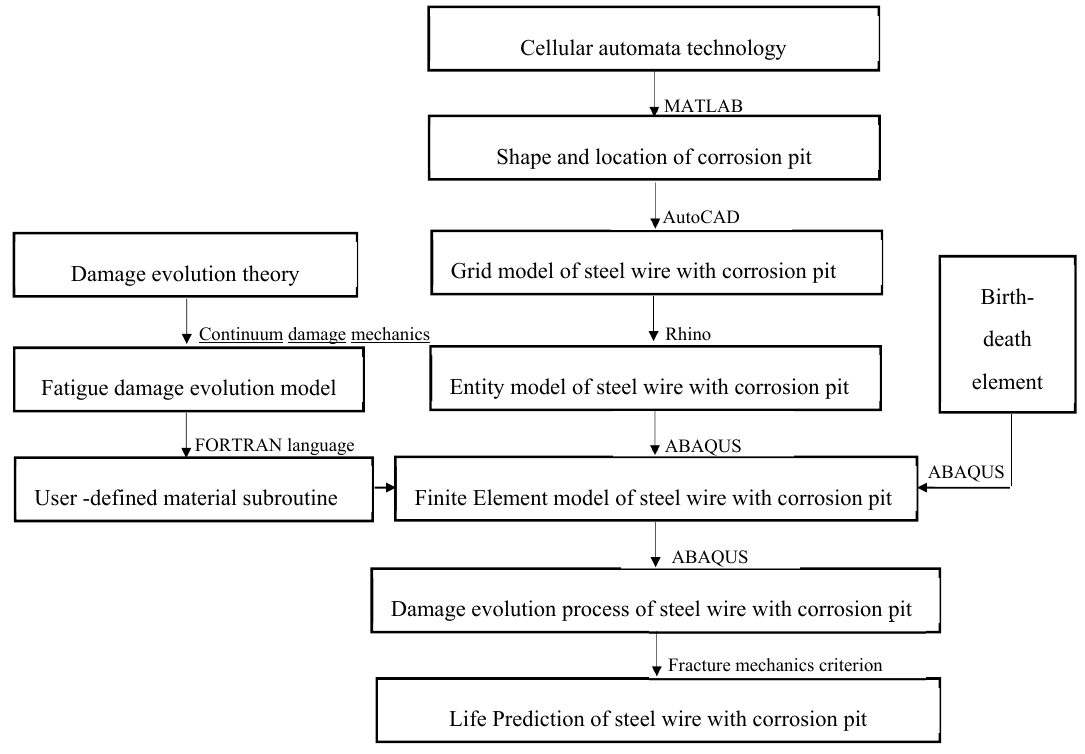
Figure 1. Flow chart of a numerical simulation of the damage evolution of high-strength steel wire under a pre-corrosion pit.